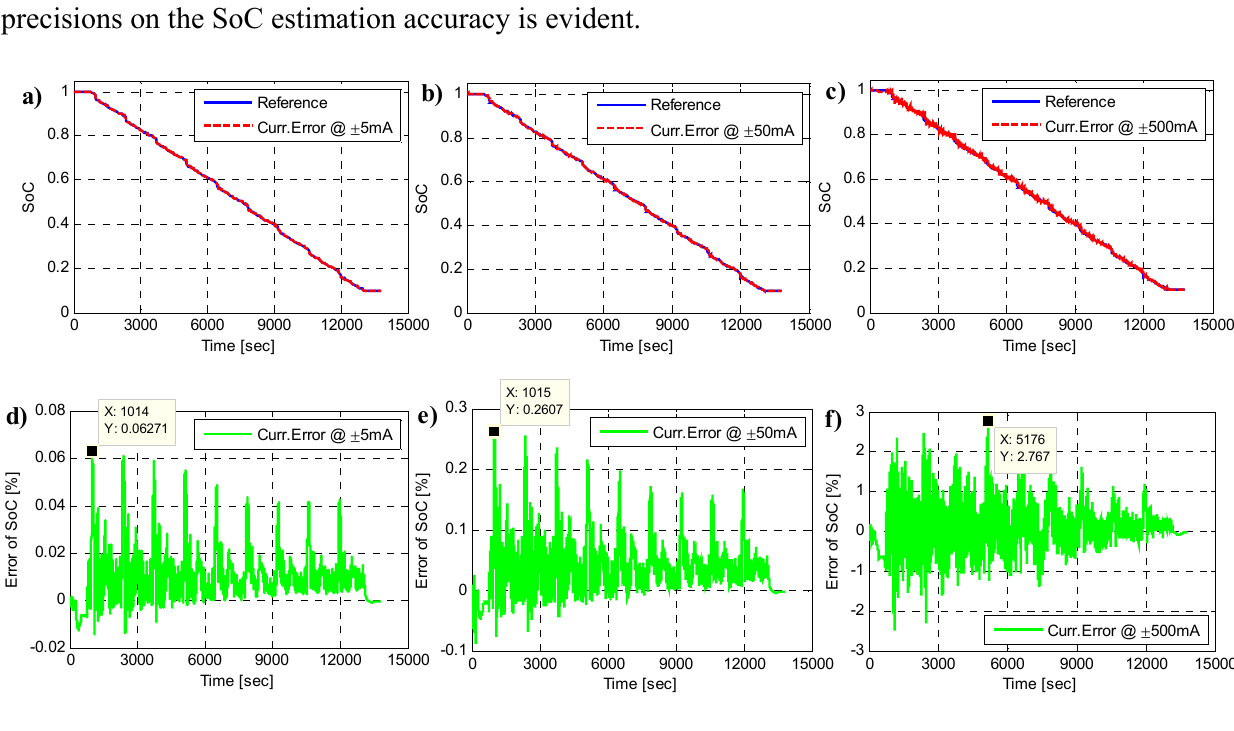
Figure 9. SoC estimation results at the current sensor precisions of ( a ) ±5 mA, ( b ) ±50 mA, ( c ) ±500 mA; and the SoC error at the current sensor precisions of ( d ) ±5 mA, ( e ) ±50 mA, ( f ) ±500